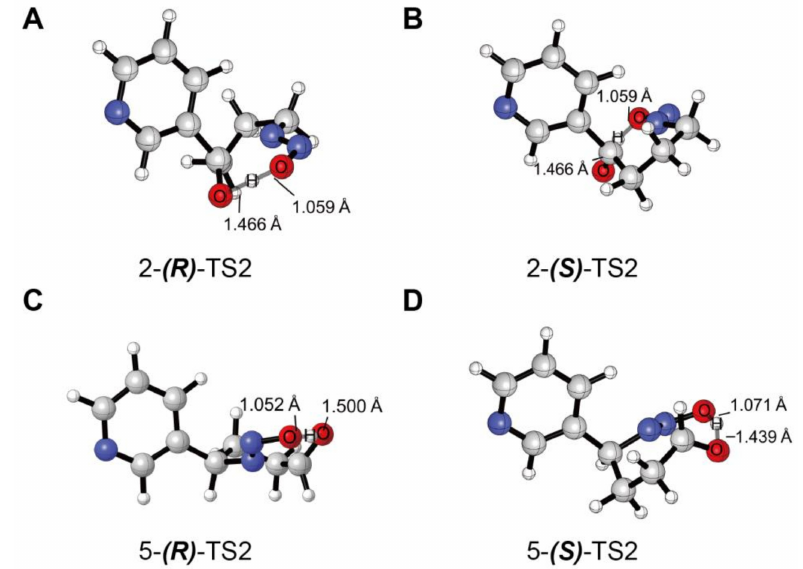
Figure 4. Optimized geometries and main parameters for the transition states of decomposition of ( R )-NNN and ( S )-NNN. Transition states of the decomposition reactions of ( R )-NNN ( A ) and ( S )-NNN ( B ) via 2 (cid:48) -hydroxylation pathway; Transition states of the decomposition reactions of ( R )-NNN ( C ) and ( S )-NNN ( D ) via 5 (cid:48) -hydroxylation pathway (distance in